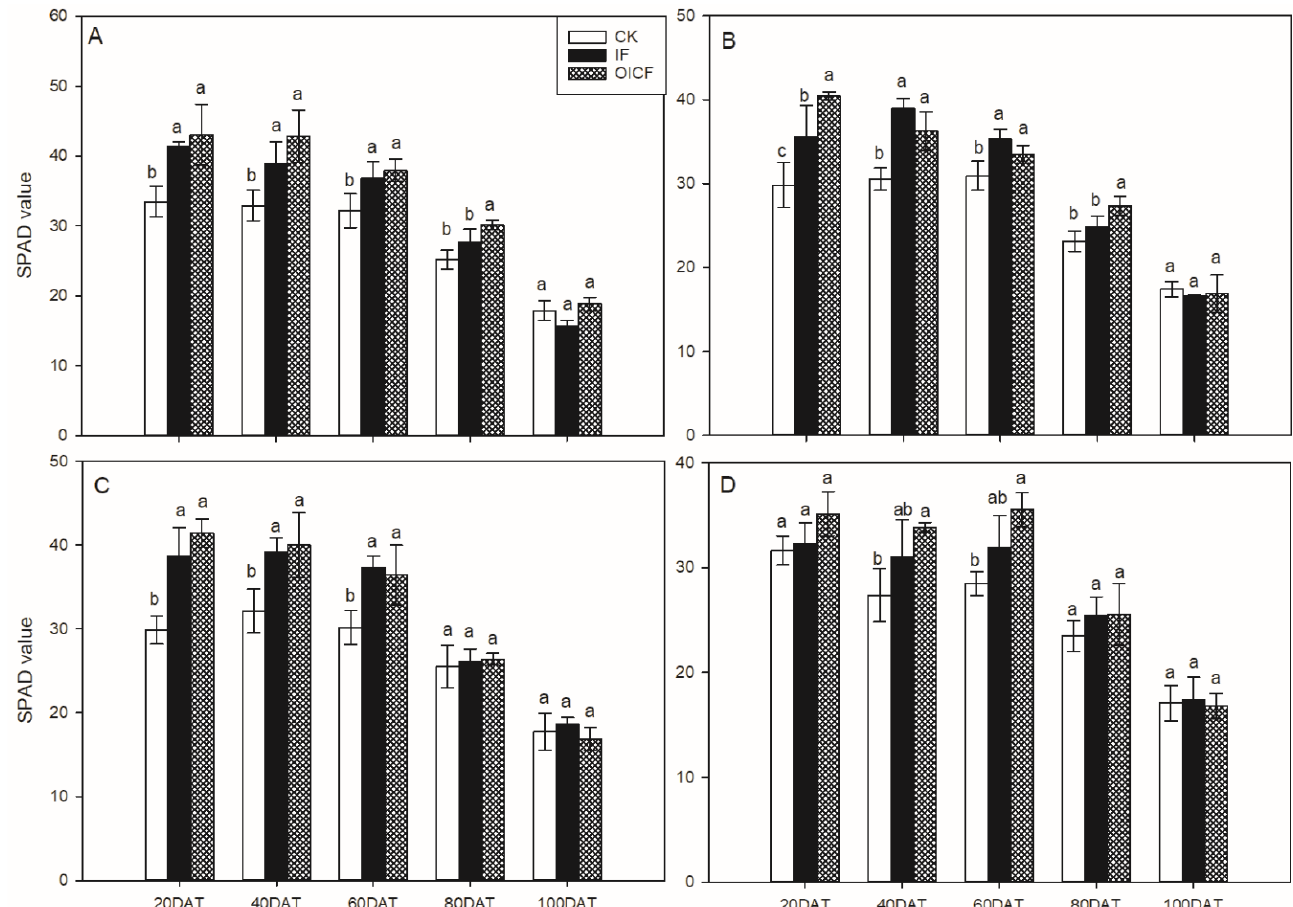
Figure 2. Effects of new organic-inorganic compound fertilizer on SPAD value of fragrant rice in 2017 ( A ), 2018 ( B ), 2019 ( C ), and 2020 ( D ). Bars sharing a common letter do not differ significantly at p ≤ 0.05.